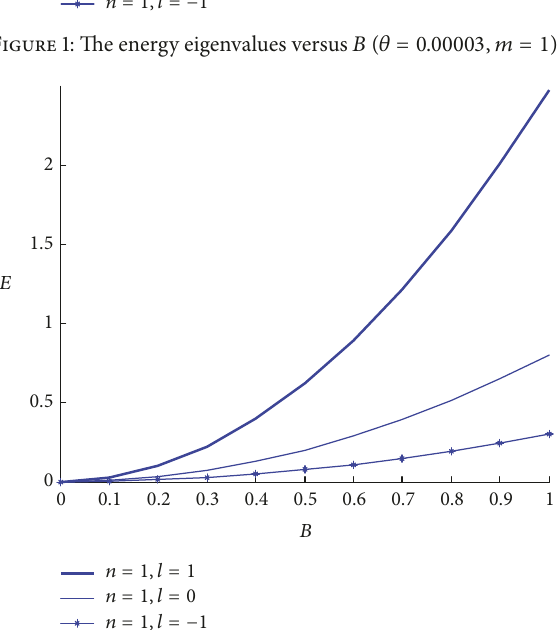
Figure 2: The energy eigenvalues versus 𝐵 ( 𝛼 = 0.05 , 𝑚 = 1 ).